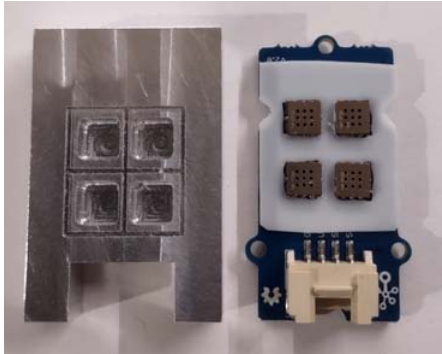
Figure 4. Three ‐ way valve. 1. The inlet of reference/cleaning gas, 2. The inlet of test gas, 3. Moving part of the three ‐ way valve, 4. Gas channels, 5. Sensor cells.